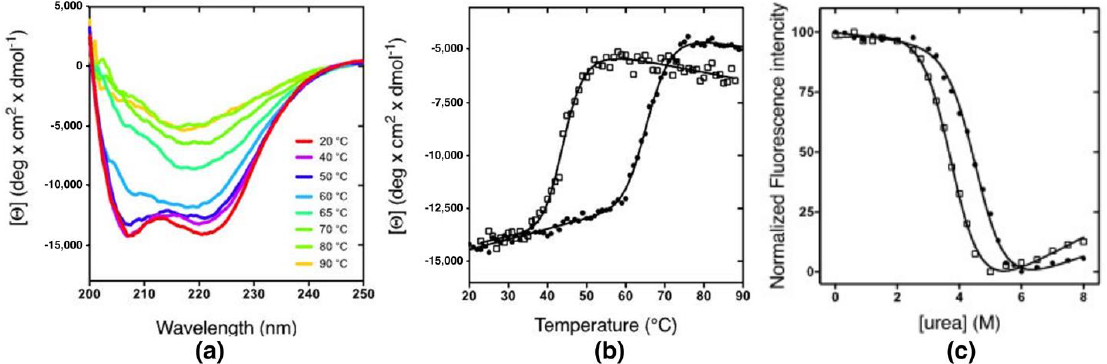
Figure 2. ( a ) Far-UV CD spectra recorded at different temperatures of KH0 measured in 20 mM sodium phosphate pH 7.2, 100 mM NaCl. ( b ) CD thermal denaturation profile of KH0 (full circles) and KH0-R138Q (empty squares) monitored by CD at 222 nm. The curves, fitted to a sigmoidal function, provided an app-T m of 68 ± 1 °C and 48 ± 2 °C for KH0 and KH0-R138Q, respectively. ( c ) Urea-induced denaturation of KH0 (full circles) and KH0-R138Q (empty squares). Fitting of the re- versible transitions (black lines ) provided the thermodynamic stability (ΔG DN ) of the two proteins (ΔG DN = 5.7 ± 0.3 and 4.7 ± 0.2 kcal mol − 1 for KH0 and KH0-R138Q, respectively). The m value was shared during fitting procedure for both proteins ( m = 1.25 ± 0.06 kcal mol − 1 M − 1 ).